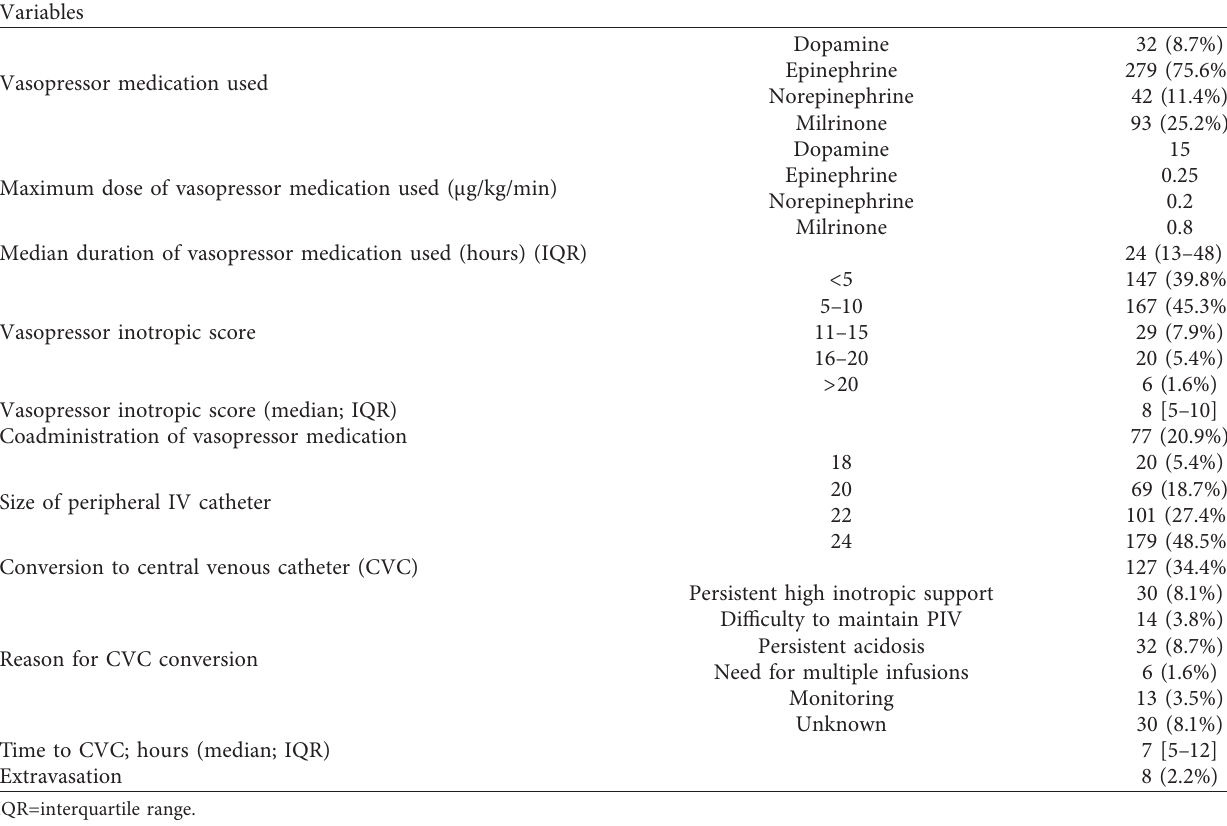
Table 2: Vasopressor use and peripheral catheter data ( n � 369).